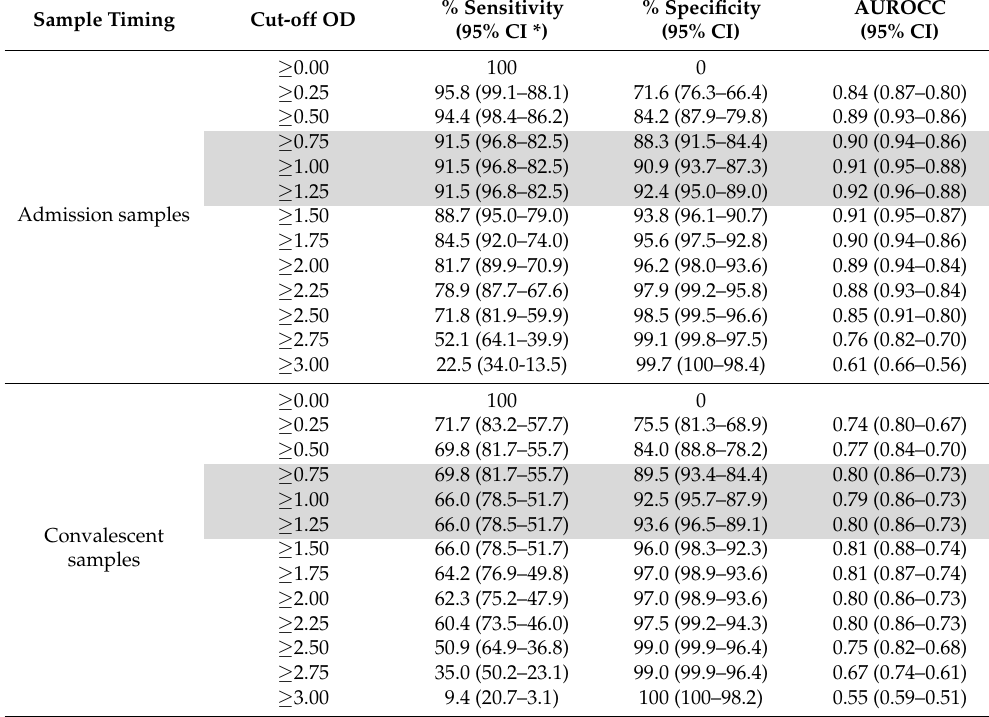
Table 2. Sensitivity, specificity, and area under receiver operator characteristic curve (AUROCC) results for admission, convalescent, and all samples for a range of diagnostic cut-off values of the InBios Scrub Typhus Detect™ IgM ELISA for IFA ≥ 1:3200 on admission or 4-fold rise to ≥ 3200. The shaded sections indicate the suggested cut-off OD for Chittagong,